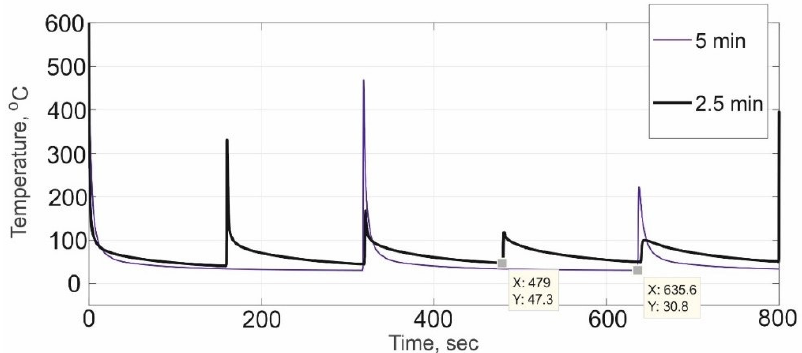
Figure 9. Comparison of thermal cycles of samples with modes 1.3 and 2.3.